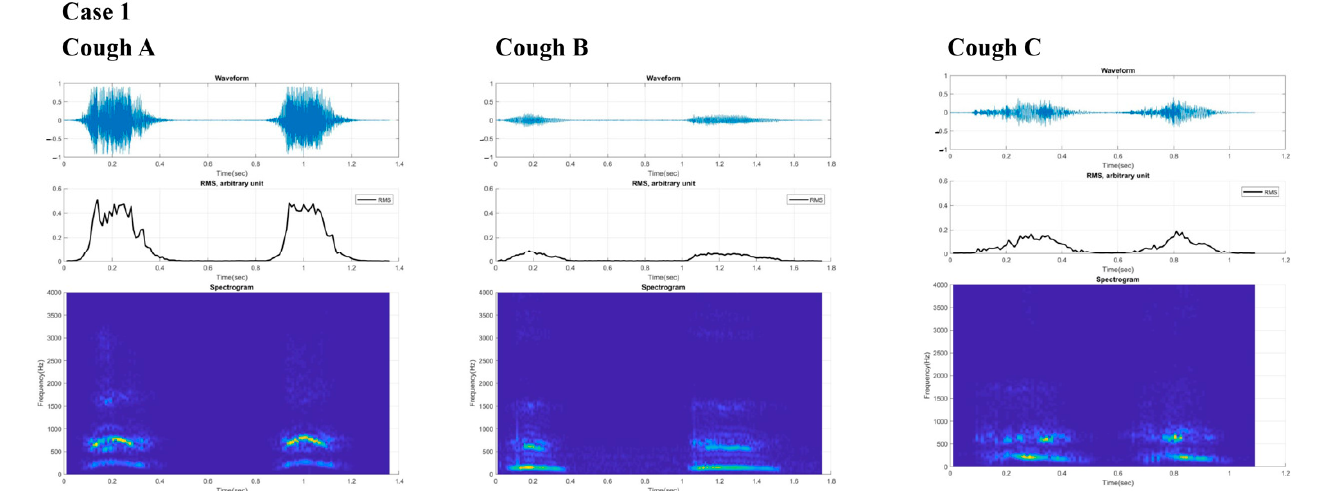
Figure 3. Digital cough sounds from Case 1 are presented for the three times, represented by several values (times) collected on different time points with cough ( A ) before aggravation, ( B ) at aggravation and poor coughing out state and cough ( C ), at recovery of cough. From top to bottom, waveform, root mean square, and spectrogram data of the cough sounds are shown. RMS = root mean square.